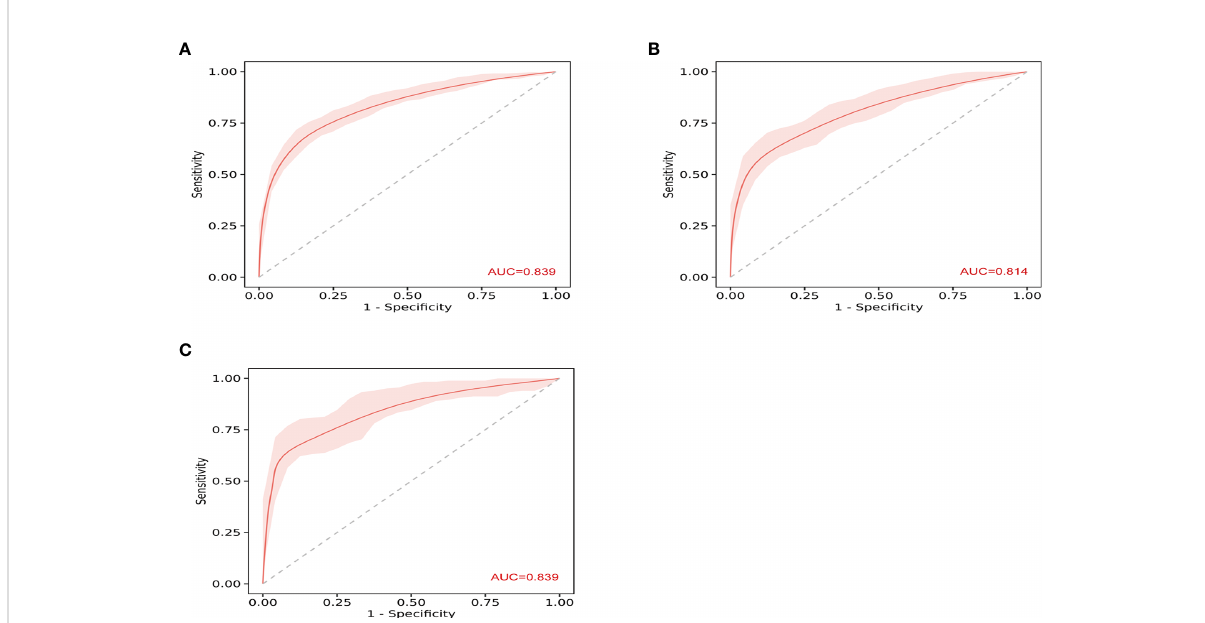
FIGURE 2 The receiver operating characteristic (ROC) curves show the discriminative ability of prediction model. (A) The area under the curve (AUC) in the training set was 0.839 (95% CI: 0.81 – 0.87). (B) The AUC in the internal validation was 0.814 (95% CI: 0.77 – 0.86). (C) The AUC in the external validation was 0.839 (95% CI: 0.79 – 0.89).